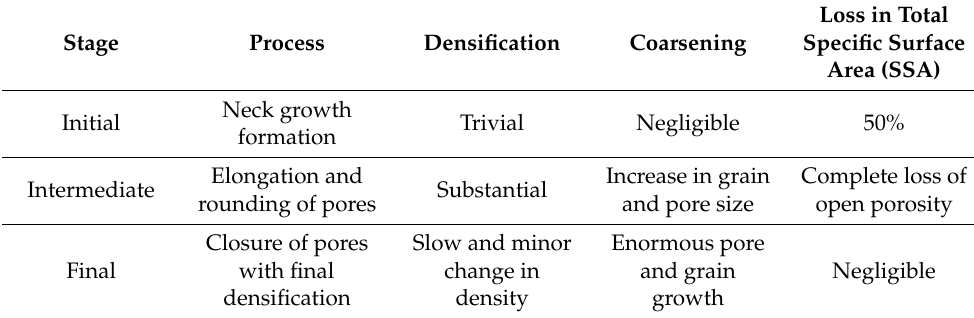
Table 2. Stages in the sintering process.